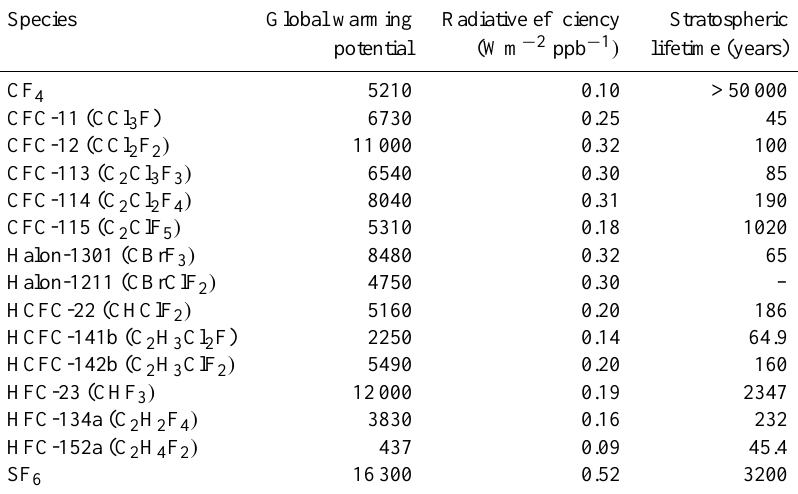
Table 1. The global warming potential, on a 20yr timescale (Solomon et al., 2007), the radiative efficiencies (Solomon et al., 2007) and the lifetimes (Montzka et al., 2011) of some of the species used in this work.